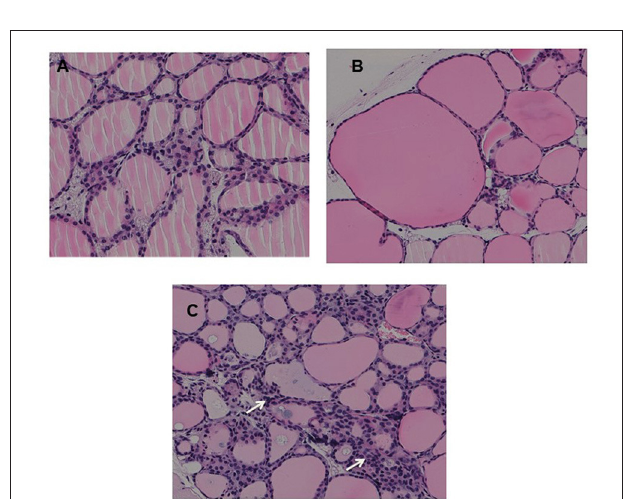
FIGURE 7 | Thyroid histology of immunized animals: Images of H&E stained slides were obtained using the Hamamatsu NanoZoomer digital scanner at 20x magnification and analyzed and depicted here by NDP.view2 software at 15x magnification. (A) Normal control mouse thyroid (B) Enlarged thyroid follicles (C) Dense micro infiltrates. These changes marked by arrow were all seen in some high hinge positive mice (2 out of 5 hTSHR immunized mice). The changes could not be conclusively associated with these antibodies because of the heterogeneity of the response observed in these immunized animals.